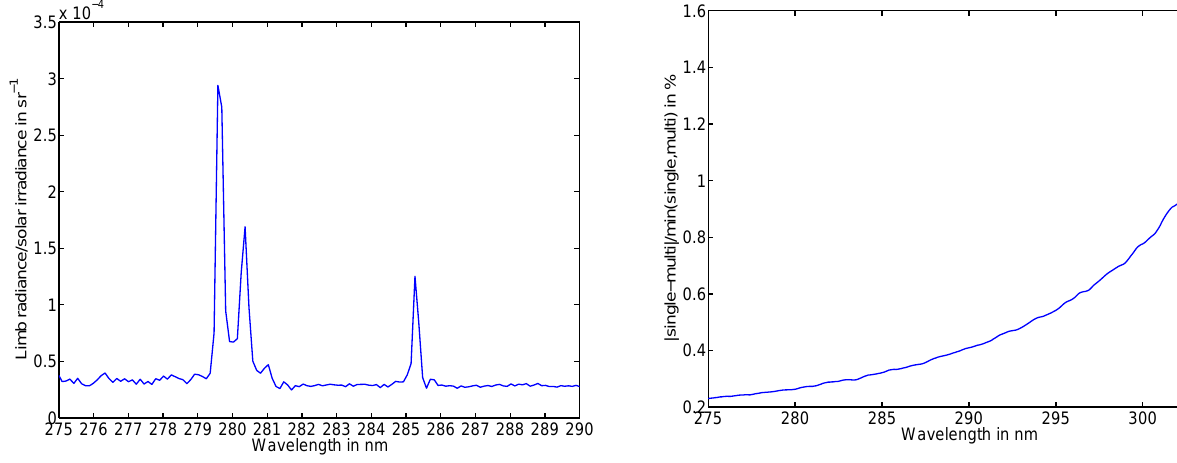
Fig. 1. Limb radiance divided by solar irradiance (average 2008– 2012, Equator, tangent altitude 89.3km). Division of both spectra leads to a smooth background signal in contrast to emission lines, which are clearly identified. The background signal is separated from the emission lines through a linear fit. Note that relative to the strong Mg + at 279.6 and 280.4nm and the strong Mg line at 285.2nm, very weak NO lines can be observed at the longer wave- length edge of the Mg + lines at 281nm. However, this influence is negligibly small.